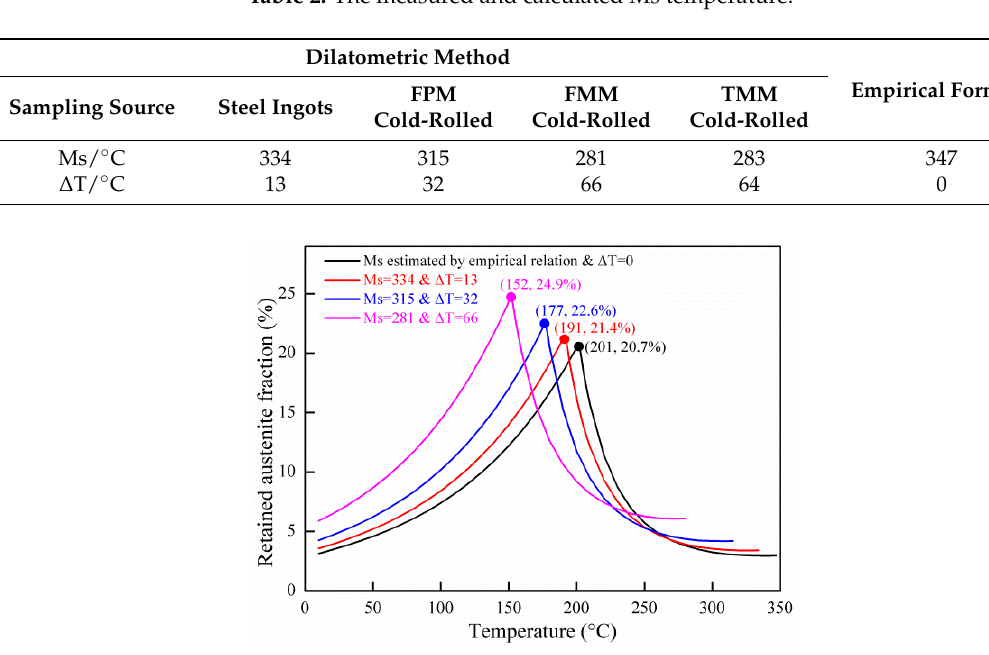
Table 2. The measured and calculated Ms temperature.